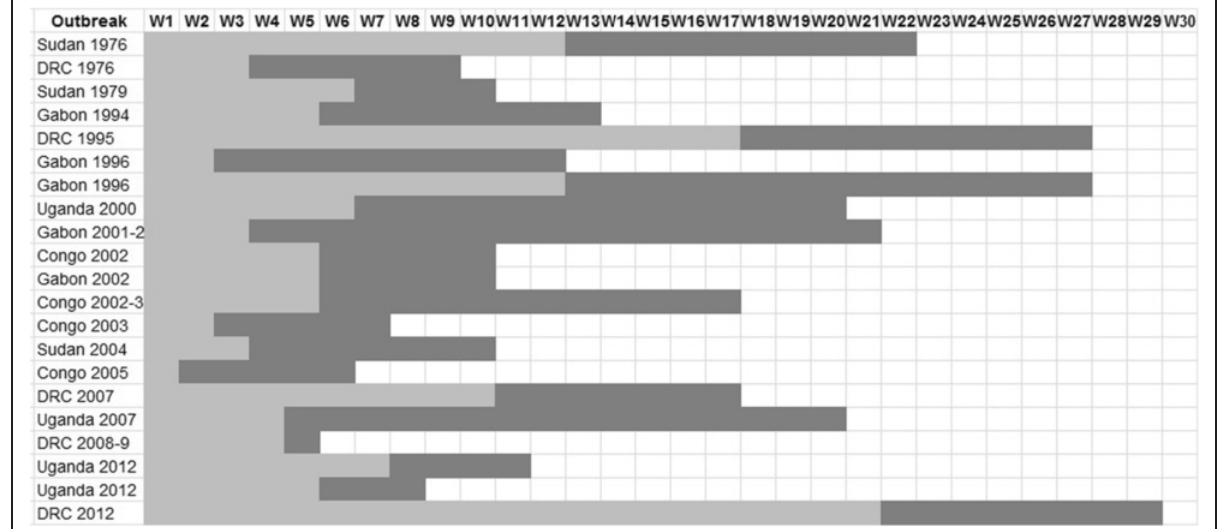
Figure 6 Alert delay and duration of the African Ebola